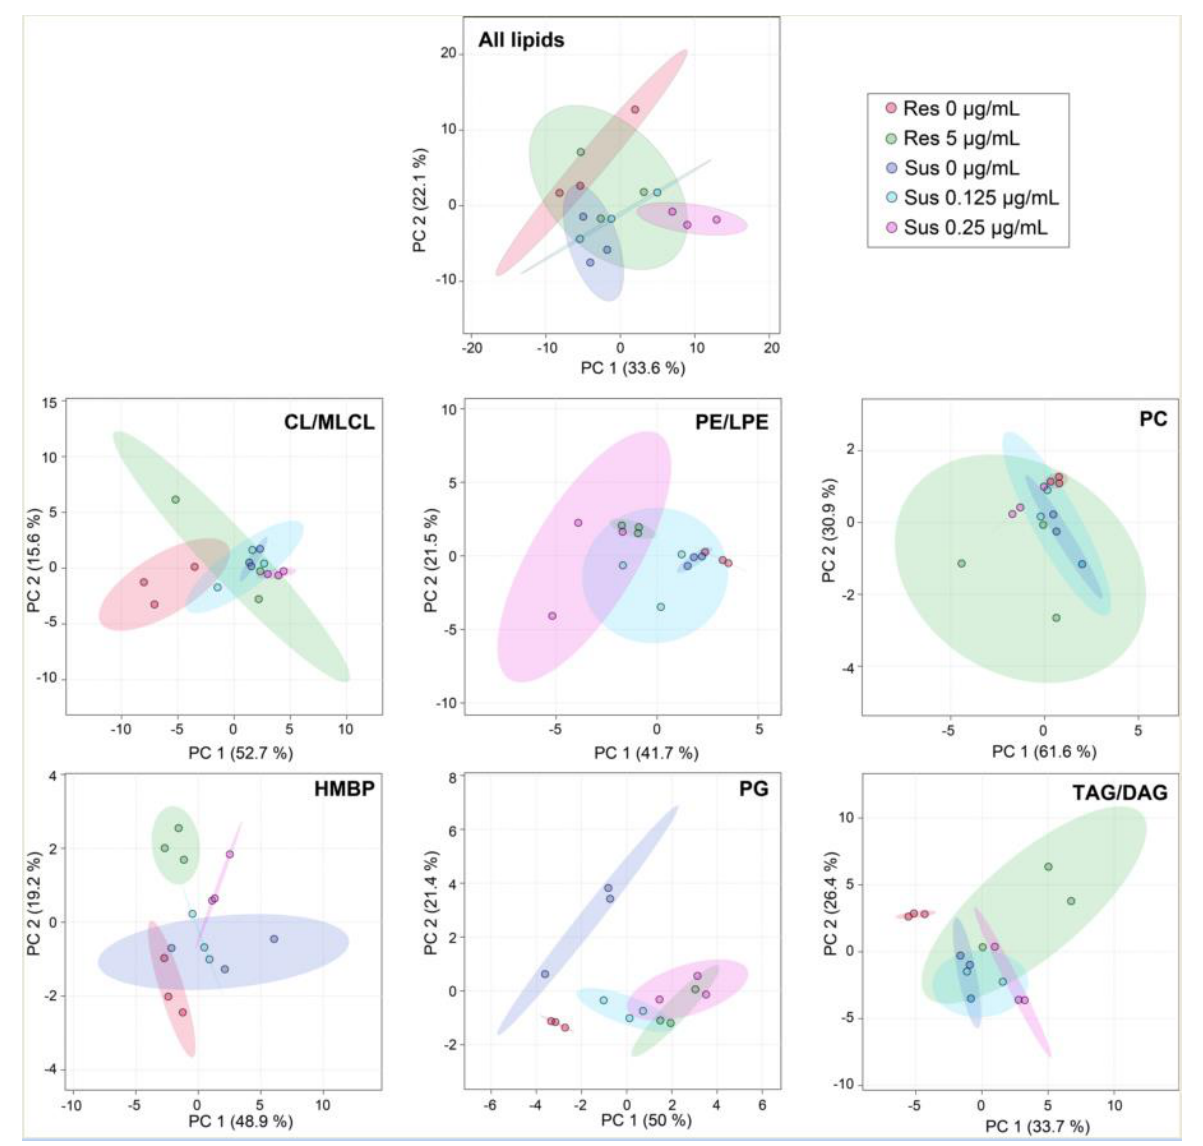
Figure 1. Low concentrations of colistin alter Acinetobacter baumannii lipid profiles. PCA scores plot showing variances in lipid species between susceptible strains without and with colistin at 0.125 µg/mL or 0.25 µg/mL and resistant without or with colistin at 5 µg/mL of Acinetobacter baumannii 721164. The results correspond to n = 3 biologically independent samples. Ellipses represent 95% confidence intervals. The analysis was performed using MetaboAnalyst V5.0 (https://www.metaboanalyst.ca/, accessed on 15 January 2021).